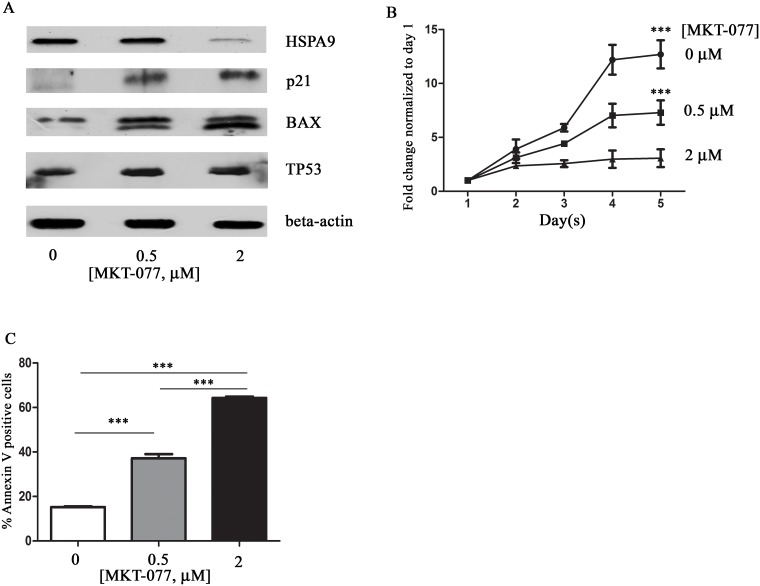
HSPA9 inhibitor MKT-077 reduces cell growth, induces apoptosis, and increases p21 and BAX expression in CD34+ cells.(A) Immunoblot of HSPA9, p21, BAX and TP53 following MKT-077 treatment of CD34+ cells grown in erythroid culture conditions for 5 days. (B) CD34+ cells were seeded at equal concentrations in erythroid culture conditions, and the total number of cells was counted daily in the presence of MKT-077. The fold change in cell counts was calculated relative to the number of cells on day 1 (n = 3) (0.5 μM versus control, p<0.001; 2 μM versus control, p<0.001). (C) Quantification of Annexin V+ cells (a surrogate for apoptosis) following treatment of CD34+ cells with various concentrations of MKT-077 for 5 days (n = 3). ***p<0.001.